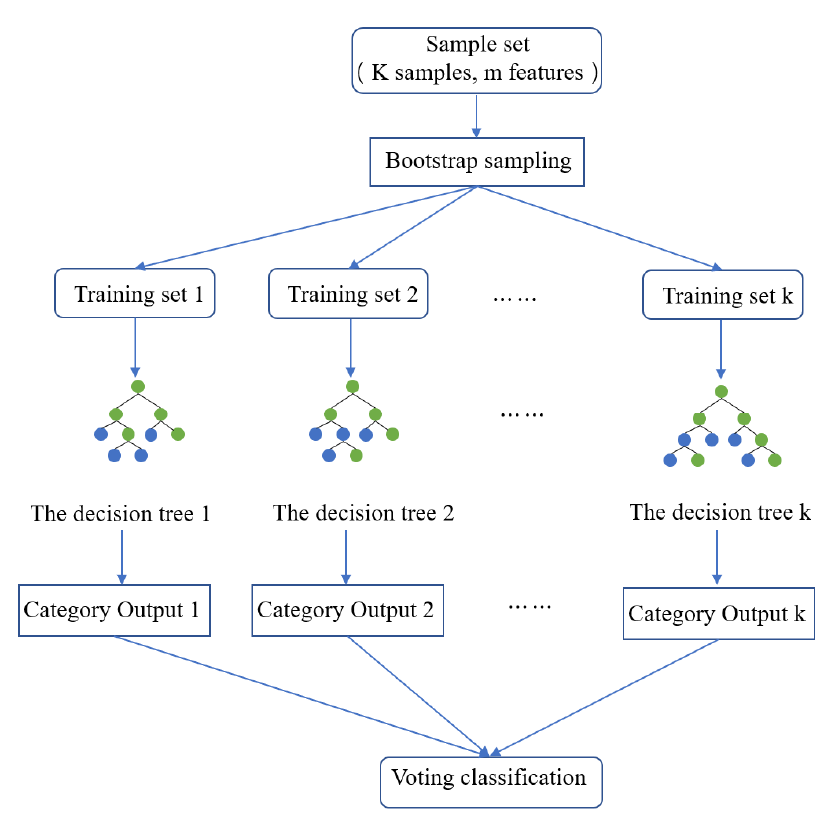
Figure 3. Schematic diagram of random forest classifier.